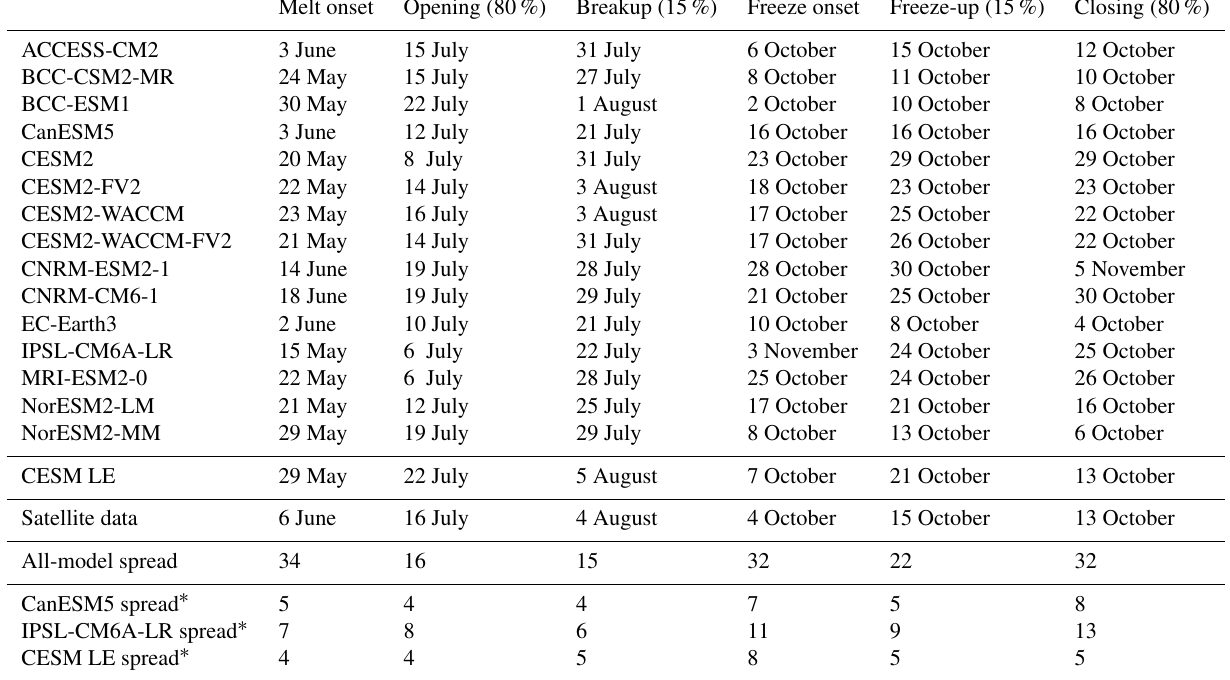
Table 3. Pan-Arctic, satellite-era (1979–2014) means of seasonal sea ice transition dates. The satellite-era means and the all-model spreads (latest minus earliest) are calculated using the first ensemble member from each model. Models labeled with ∗ show the spread in means between the first 30 ensemble members of that model. Model spreads are given in days, and all metrics are calculated between 66 and 84.5 ◦ N.